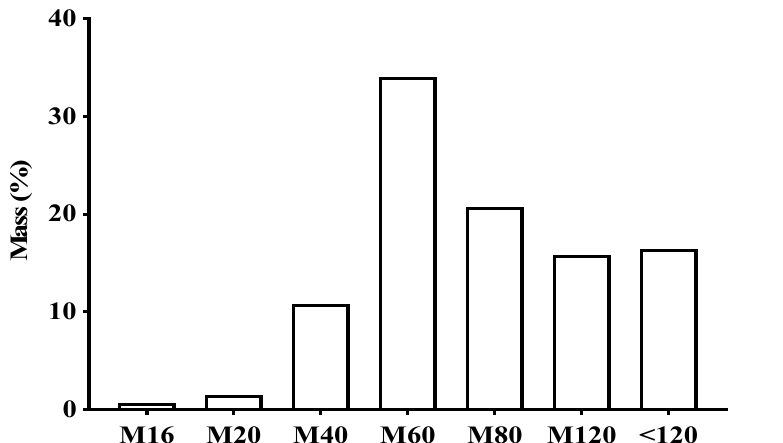
Figure 1. Percentage of different particles sizes in the powder of dry Vismia guianensis leaves after grinding and sifting using different mesh sizes.